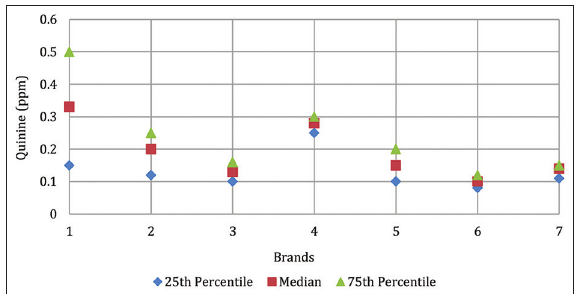
FIGURE 1: Quinine content in energy drinks brands.